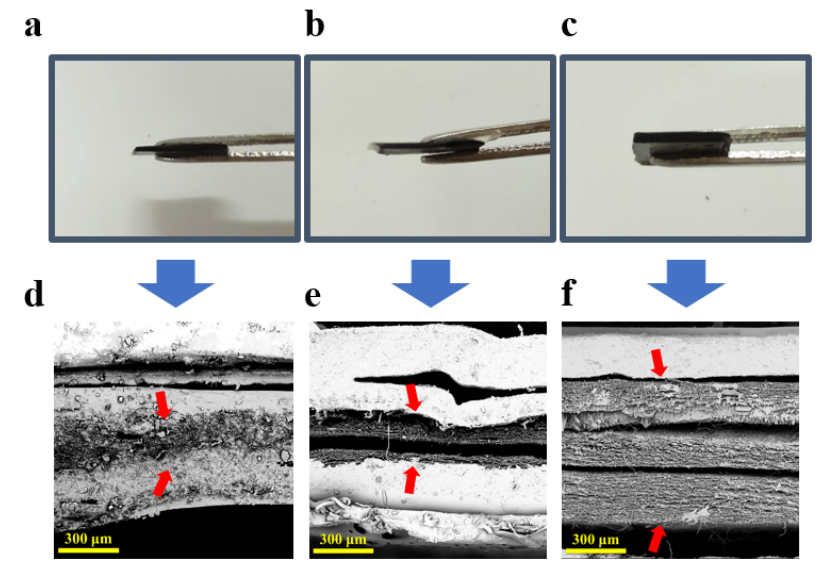
Figure 9. Cross section image of SF/Gr pressure sensor. ( a ) cross section of a pressure sensor with only one SF/Gr nanofiber membrane; ( b ) pressure sensor formed by two SF/Gr nanofiber membranes superimposed; ( c ) pressure sensor formed by three SF/Gr nanofiber membranes superimposed. Subfigures ( d – f )—cross section SEM images of ( a – c ) respectively.